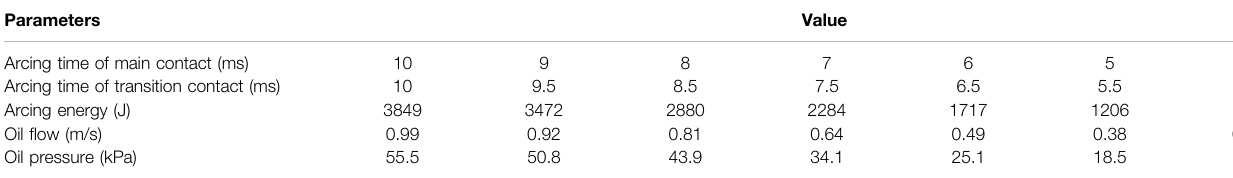
TABLE 4 | Oil fl ow velocity and oil pressure under switching times. Parameters